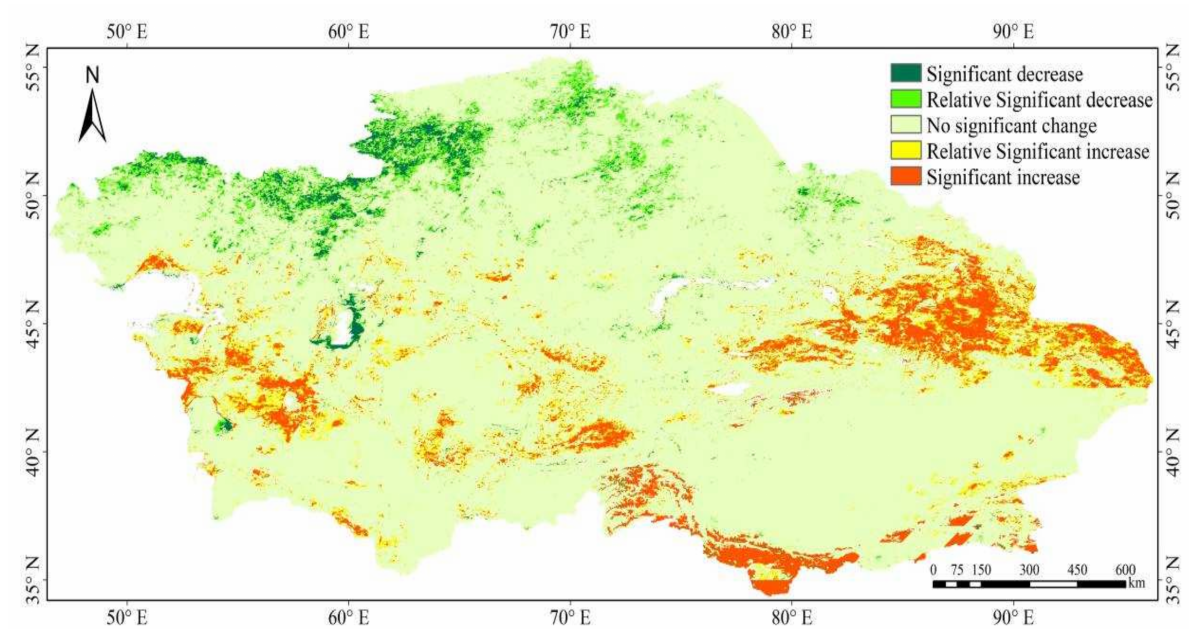
Figure 7. Distribution of the inter-annual variation trends for the AOD in Central Asia from 2001 to 2020.